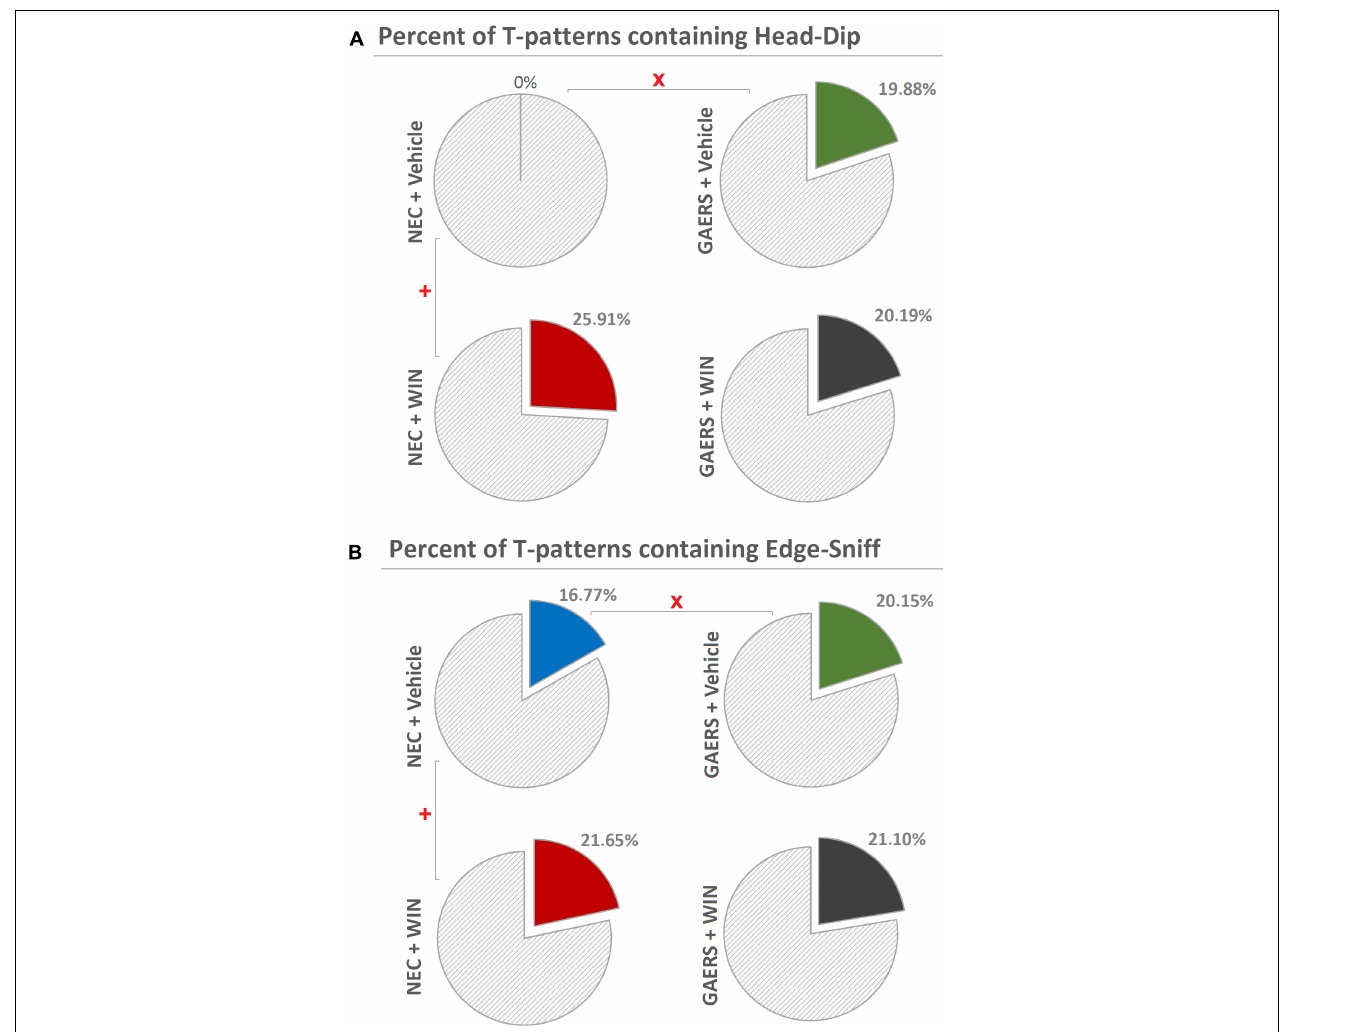
FIGURE 7 | Effect of WIN 55,212-2 and its vehicle on the percent distribution of T-patterns containing Head-Dip and Edge-Sniff in GAERS and NEC rats. Administration of WIN 55,212-2 (WIN; 2 mg/kg, IP) and its vehicle affected the percent distribution of T-patterns containing Head-Dip (A) and Edge-Sniff (B) in their sequences during the 10 min of the hole-board test. x = significant ( p < 0.05) difference between GAERS Vehicle vs. NEC Vehicle (Chi-Square test). + = significant ( p < 0.05) difference between GAERS WIN vs. GAERS Vehicle or between NEC WIN vs. NEC Vehicle (Chi-Square